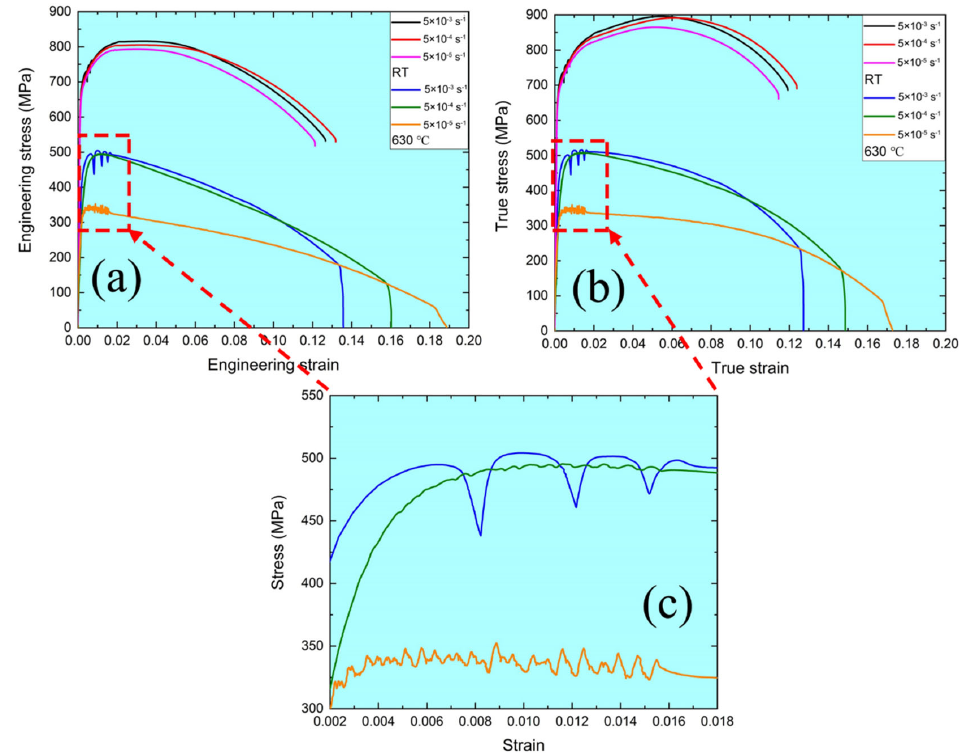
Figure 3. Stress-strain curves of tensile samples under different strain rates at RT and 630 ◦ C: Figure 3. Stress ‐ strain curves of tensile samples under different strain rates at RT and 630 °C: ( a ) engineering stress ‐ strain curves; ( b ) true stress ‐ strain curves; ( c ) the magnified image for the red ( a ) engineering stress-strain curves; ( b ) true stress-strain curves; ( c ) the magnified image for the red dotted rectangle in Figure 3a,b. dotted rectangle in Figure 3a,b.